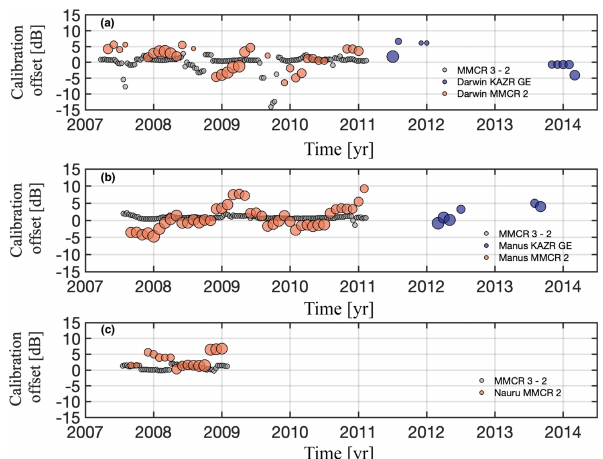
Figure 9. The calibration offset for the MMCR mode 2 and KAZR GE mode at the Tropical Western Pacific (TWP) sites of (a) Darwin, (b) Manus, and (c) Nauru based on the ARM–CloudSat compari- son. The size of the circles indicates the ratio of the sample size of the CloudSat columns for any given calibration offset estimate rel- ative to the maximum sample size of CloudSat columns observed during the same period by the same mode. The gray circles indicate the ARM mode 3–mode 2 difference as estimated from the ARM radar mode